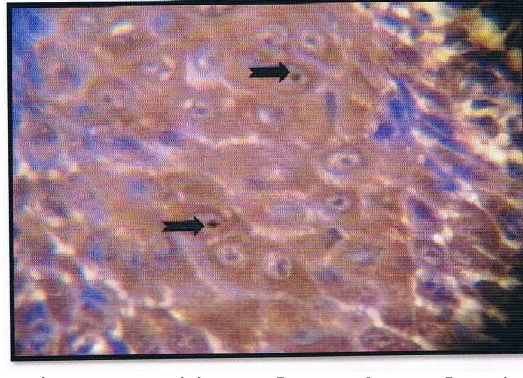
Figure 6: Positive nuclear and cytoplasmic expression of p21 in moderately differentiated SCC. (400X)